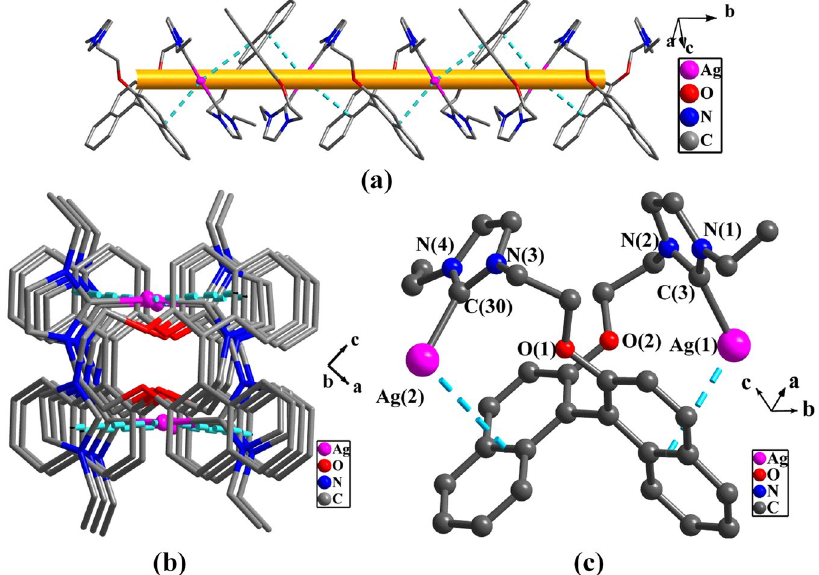
Figure 7. ( a ) 1D polymeric chains of complex 4 ; ( b ) The view of b axis; ( c ) Perspective view of the monomer. All hydrogen atoms were omitted for clarity. Selected bond lengths (Å) and angles (°): C(3)-Ag(1) 2.084(6),